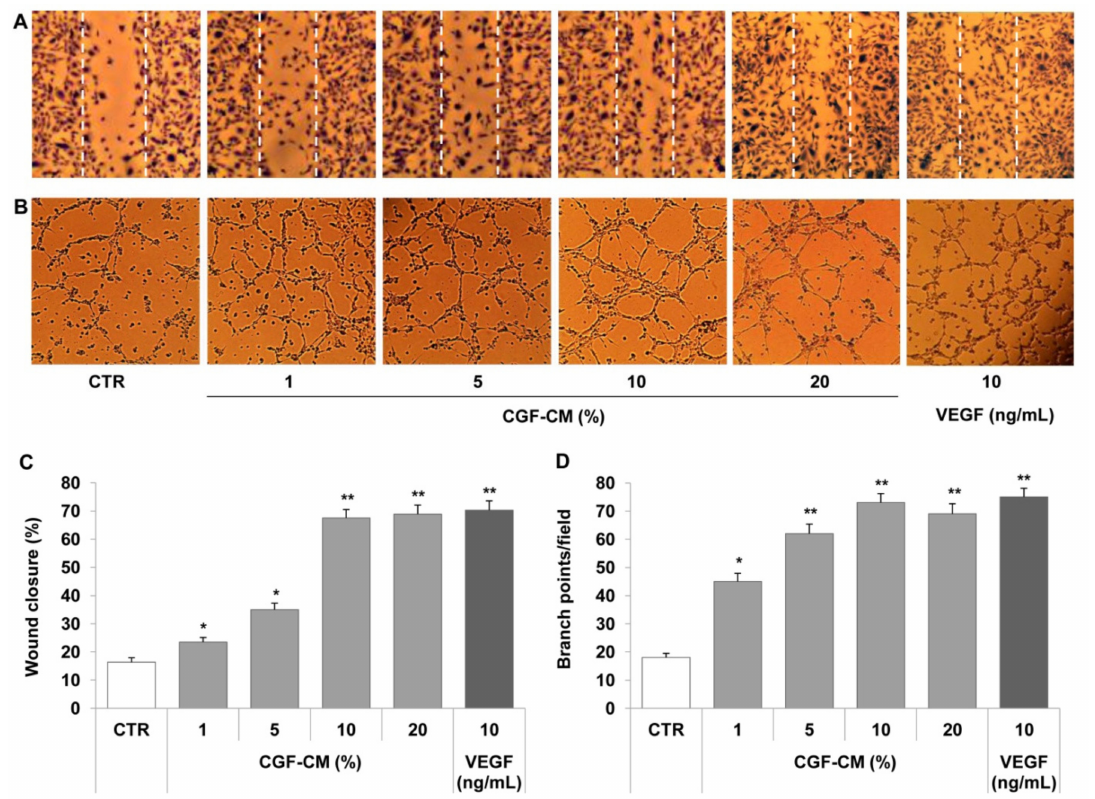
Figure 2. CGFs promote endothelial cell migration and tube formation. A scratch wound was performed on endothelial monolayers of HMEC-1 that were stimulated with CGF-CM (1%, 5%, 10% or 20%) for 16 h ( A ). Cell migration was quantified and monitored under phase-contrast microscopy ( C ). HMEC-1 cells were plated onto a three-dimensional collagen gel (Matrigel) surface and then stimulated with CGF-CM (1%, 5%, 10%, or 20%) or VEGF (10 ng/mL) for 16 h ( B , D ). Tube formation was monitored under phase-contrast microscopy, photographed, and analyzed. Images are representative of cell migration ( A ) and capillary-like tube formation ( × 100 magnification) ( B ). Data are representative of three independent experiments, expressed as means ± SD, and presented as percentage of wound closure ( C ) and branch points per field ( D ). Each experiment consisted of four replicates for each condition. * p < 0.05 and ** p < 0.01 vs. control